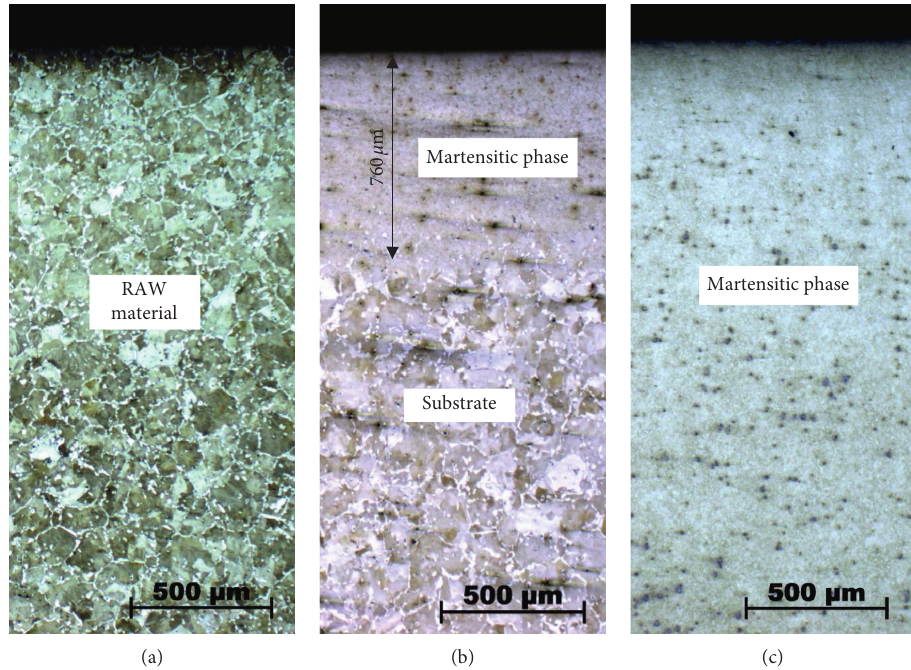
Figure 2: Comparison of the cross section of samples: (a) RAW sample, (b) LQ sample, and (c) CQT sample.